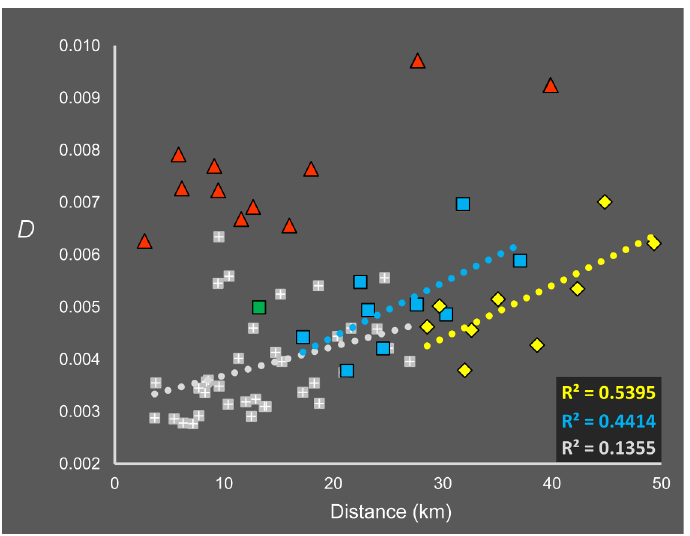
Fig 3. Relationship between pairwise Nei’s D estimatesand geographic distance. Red trianglesshow distancesinvolvingSite 4, which was highlydifferentiatedfrom all others. Yellowdiamondsdenote distances betweenSites 1,2,3,5–10 and Site 11, blue squares denotethe same but for Site 12. Distances betweenSites 11 and 12 are shown by the green square. White on grey crosses show distancesfor Sites 1,2,3,5–10.